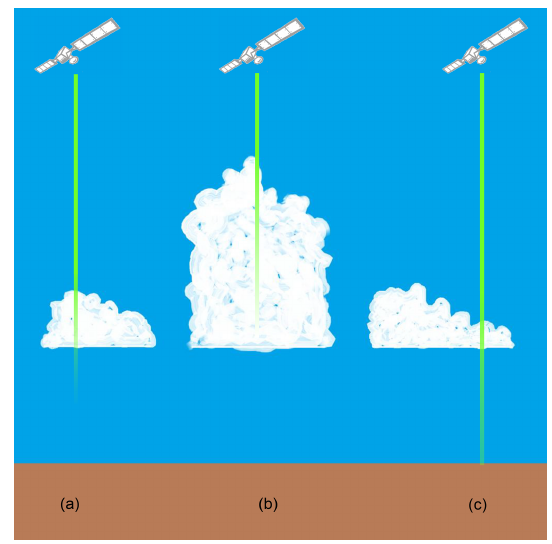
Figure 2. Schematic of CALIOP cloud base determination and evaluation strategy. In optically thick clouds (a, b) , the lidar atten- uates significantly within the cloud, rendering the cloud base infor- mation unreliable. However, z of thin clouds (c) can be used as a proxy for thick clouds in a cloud field with homogeneous z